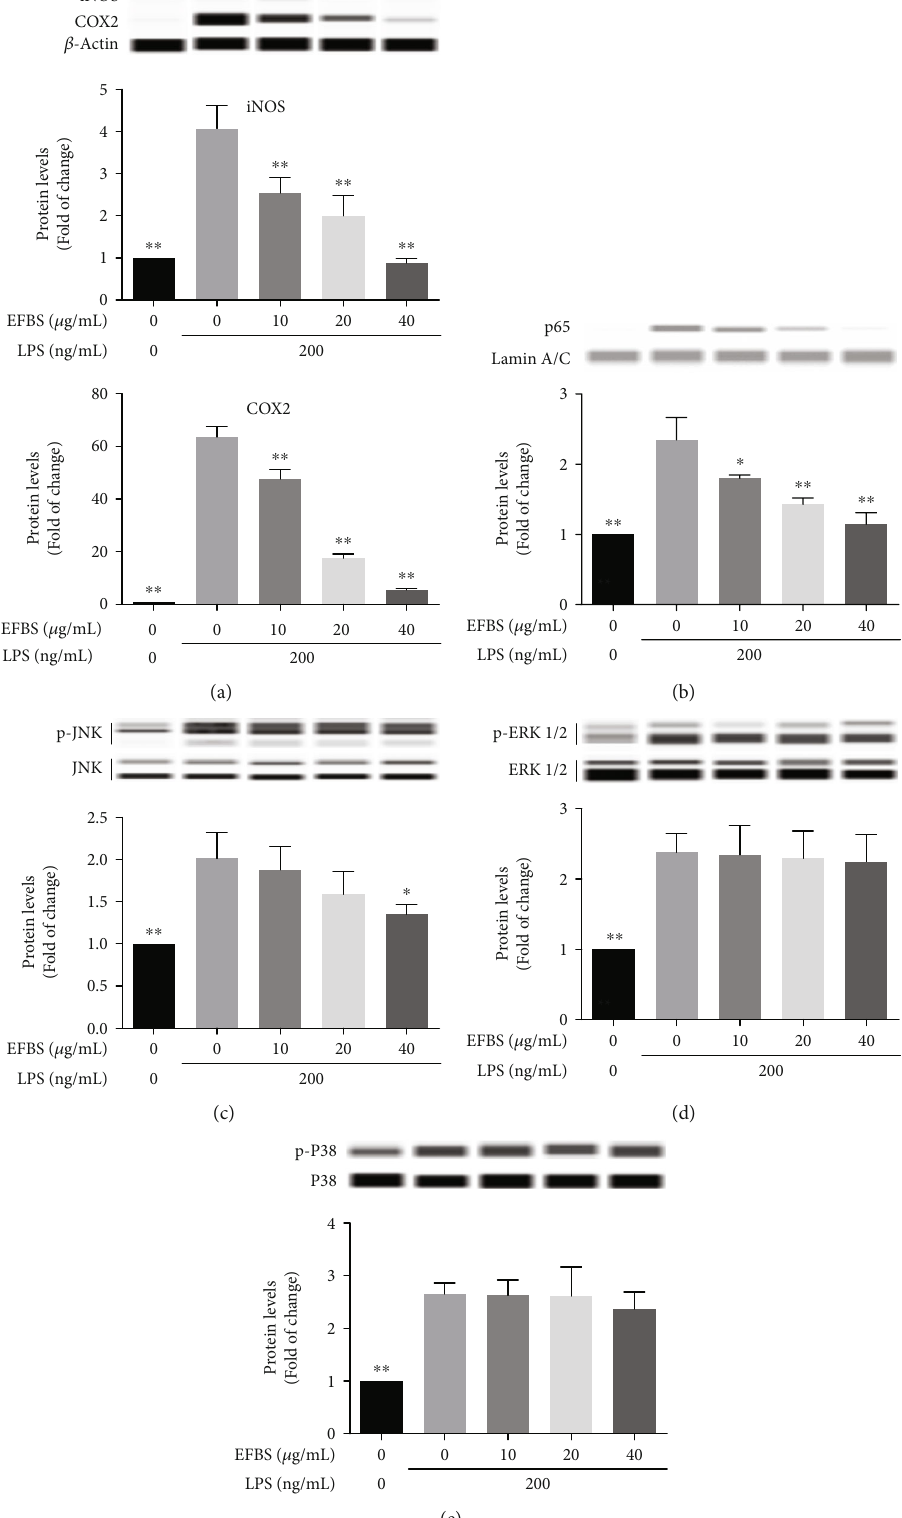
Figure 8: Regulation of EFBS on NF- κ B and MAPK signaling pathway and its inhibitory e ff ect on iNOS and COX2 expression. Statistical analysis was performed using one-way ANOVA followed by the Tukey-Kramer posttest. ∗ P < 0 : 05 , ∗∗ P < 0 : 01 compared with the LPS treatment